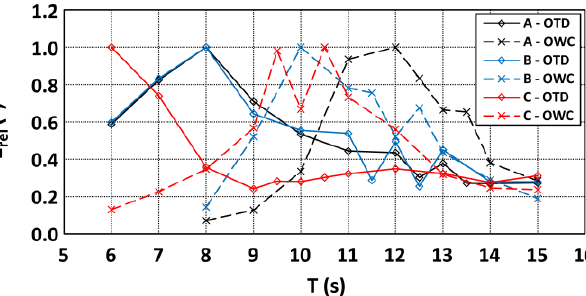
Fig. 9. Relative efficiency as a function of tested wave